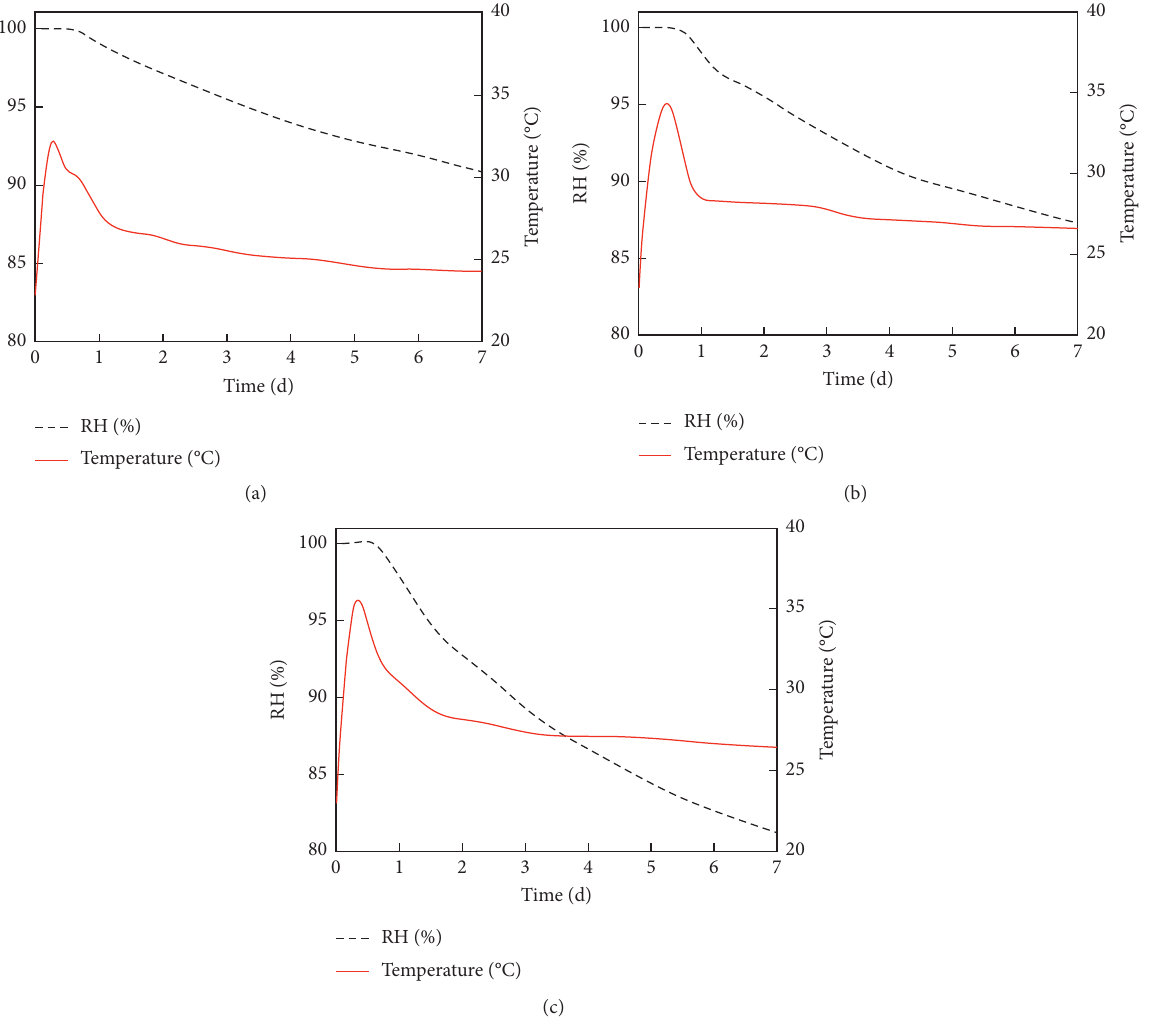
Figure 6: The relation curve of concrete internal humidity-temperature and age. (a) TS-1 concrete. (b) TS-2 concrete. (c) TS-3 concrete.